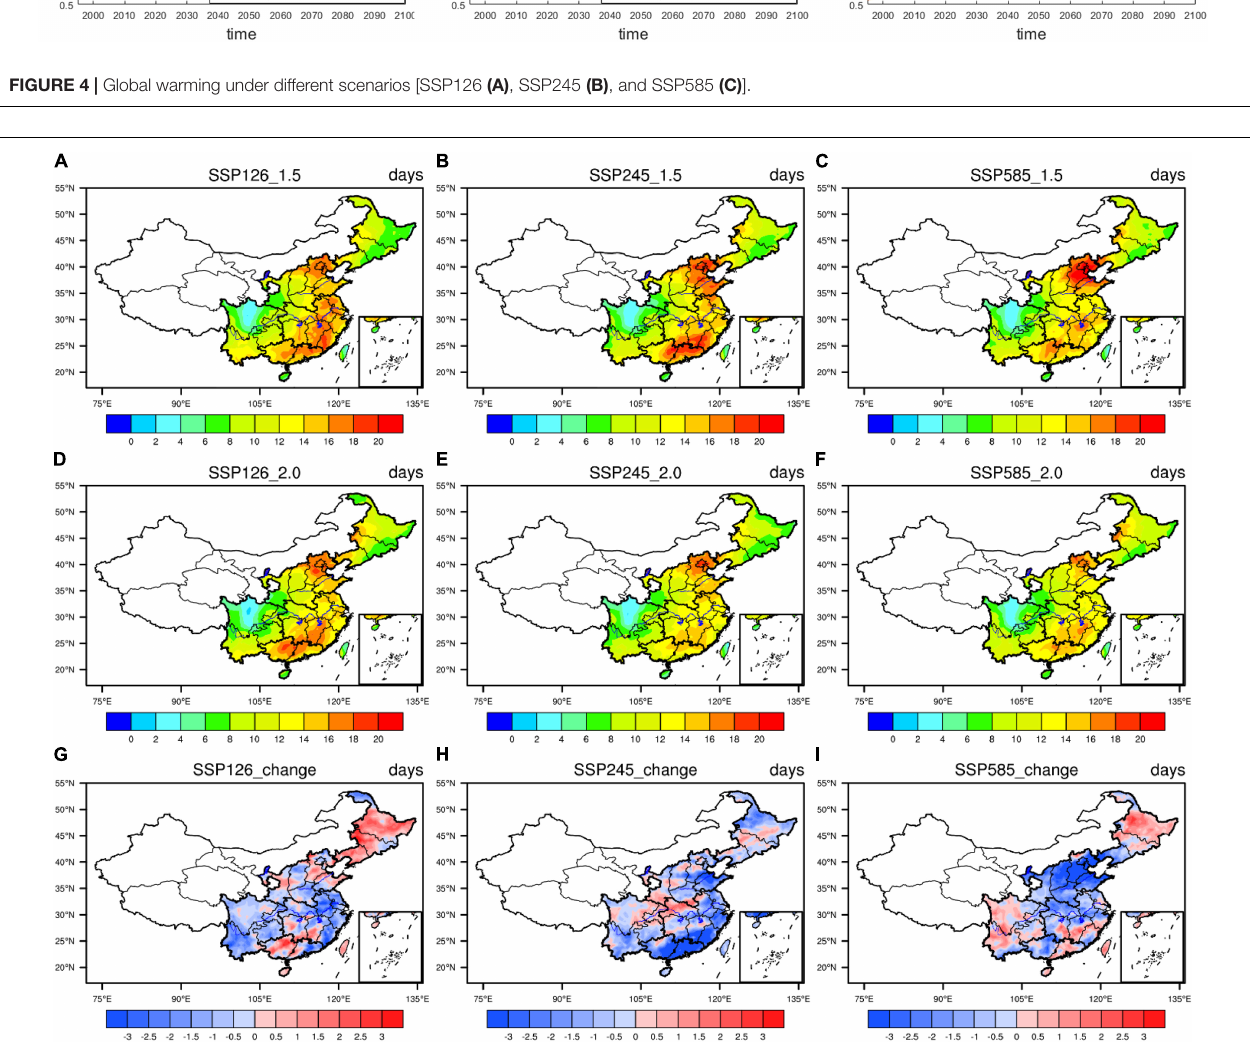
FIGURE 5 | Distribution of consecutive dry days (CDD) at 1.5 and 2 ◦ C. (A–C) Global warming at 1.5 ◦ C under SSP126, SSP245, and SSP585, respectively. (D–F) Global warming at 2 ◦ C under SSP126, SSP245, and SSP585, respectively. (G–I) The differences between global warming at 1.5 and 2 ◦ C.